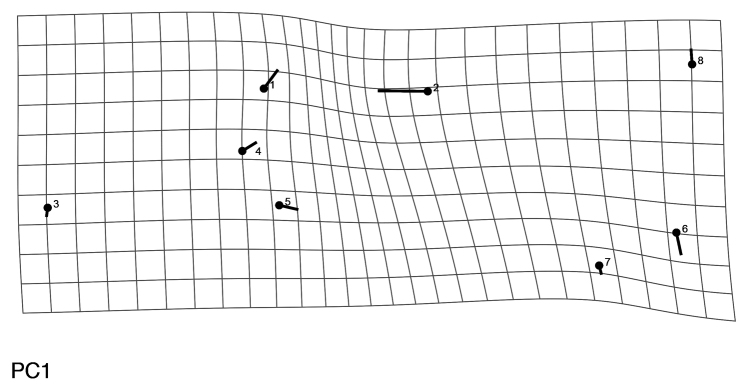

PCA thin plate showing that landmarks 1 and 2 are the most variable within the compared specimens.